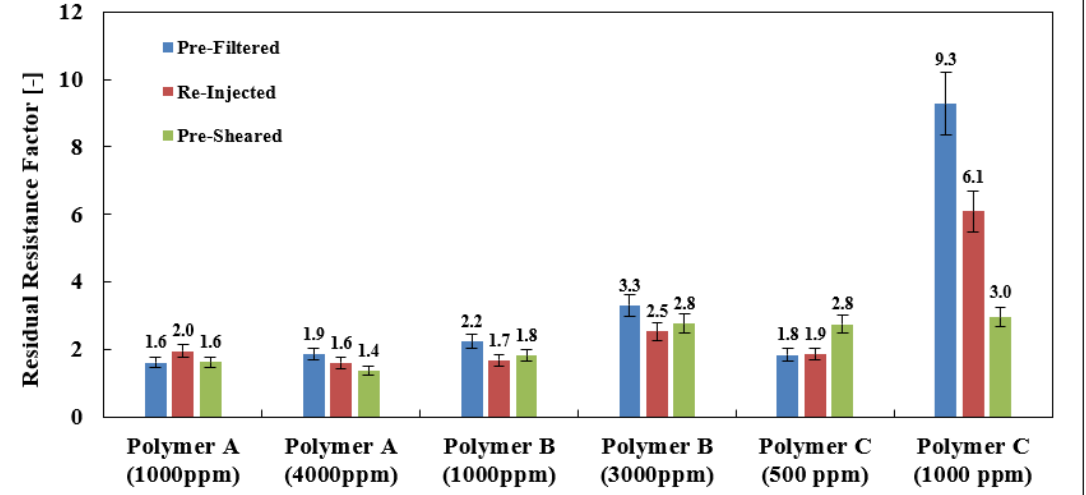
Figure 13. Residual resistance factor (RRF) of polymers A, B and C at different Figure 13 Residual resistance factor (RRF) of polymers A, B and C at different concentrations.